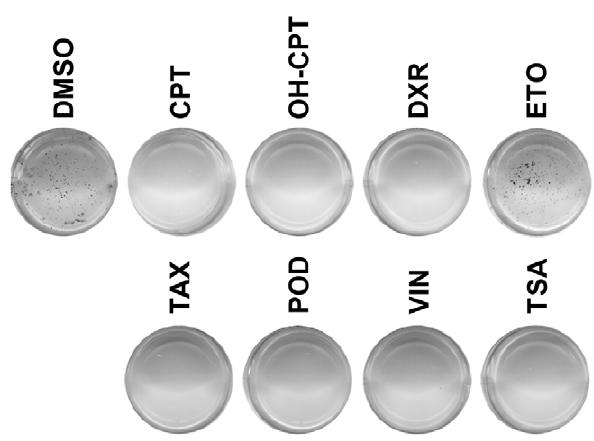
Figure 2. Inhibition of anchorage independent growth of neuroblastoma cells by selected MYC-specific compounds. SK- N-BE(2) cells were seeded in soft agar and treated with 1 m M of the eight reference compounds indicated. For each compound, the colonies were counted and representative plates from two independent experiments performed in duplicates are presented. DMSO treated cells were used as control.